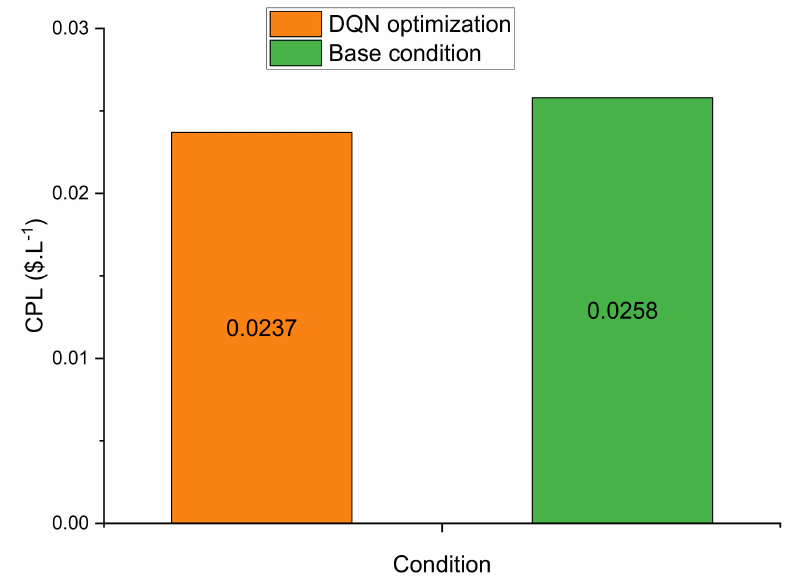
Figure 11. The costs per liter (CPL) for the investigated systems.